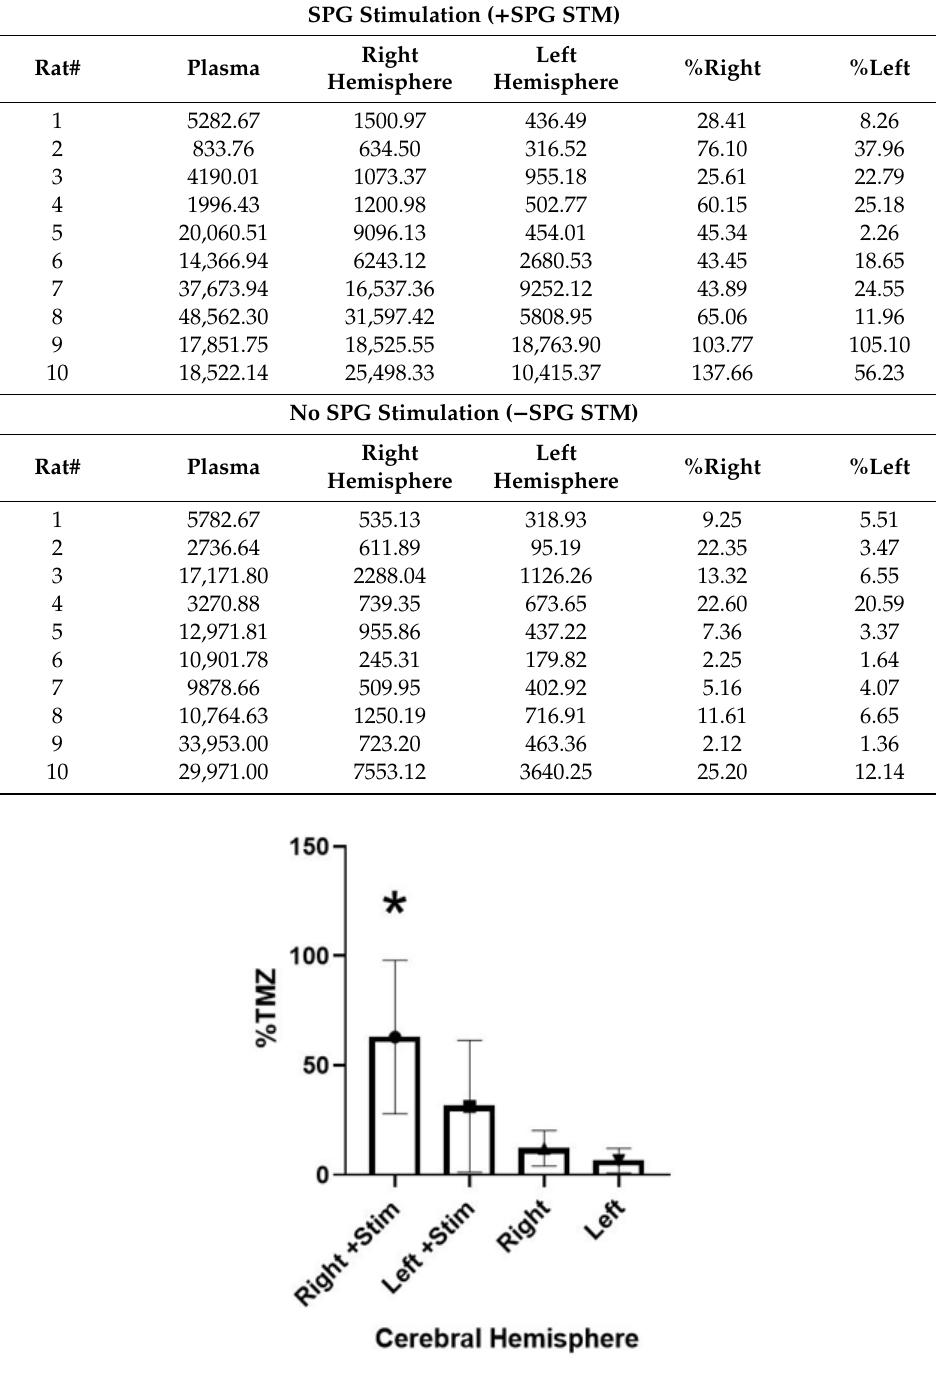
Figure 6. SPG Stimulation Significantly Upregulates Intra-Arterial TMZ Across the BBB. TMZ was administered intra-arterially, at a low dose of 50 mg/kg over a slow 5-min bolus. Rats were harvested 30 min after the drug administration and SPG stimulation (if applicable). The right cerebral hemisphere with SPG stimulation showed an average five-fold upregulation of temozolomide in brain parenchyma ( p = 0.0006) compared to the right cerebral hemispheres of rats without SPG stimulation. Asterisk denotes statistically significant value.